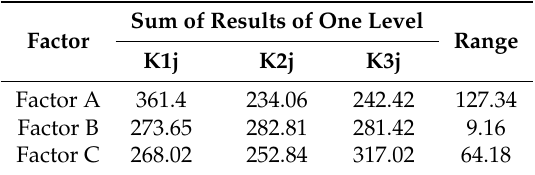
Table 10. Range analysis of orthogonal experiment of wear rate as the target